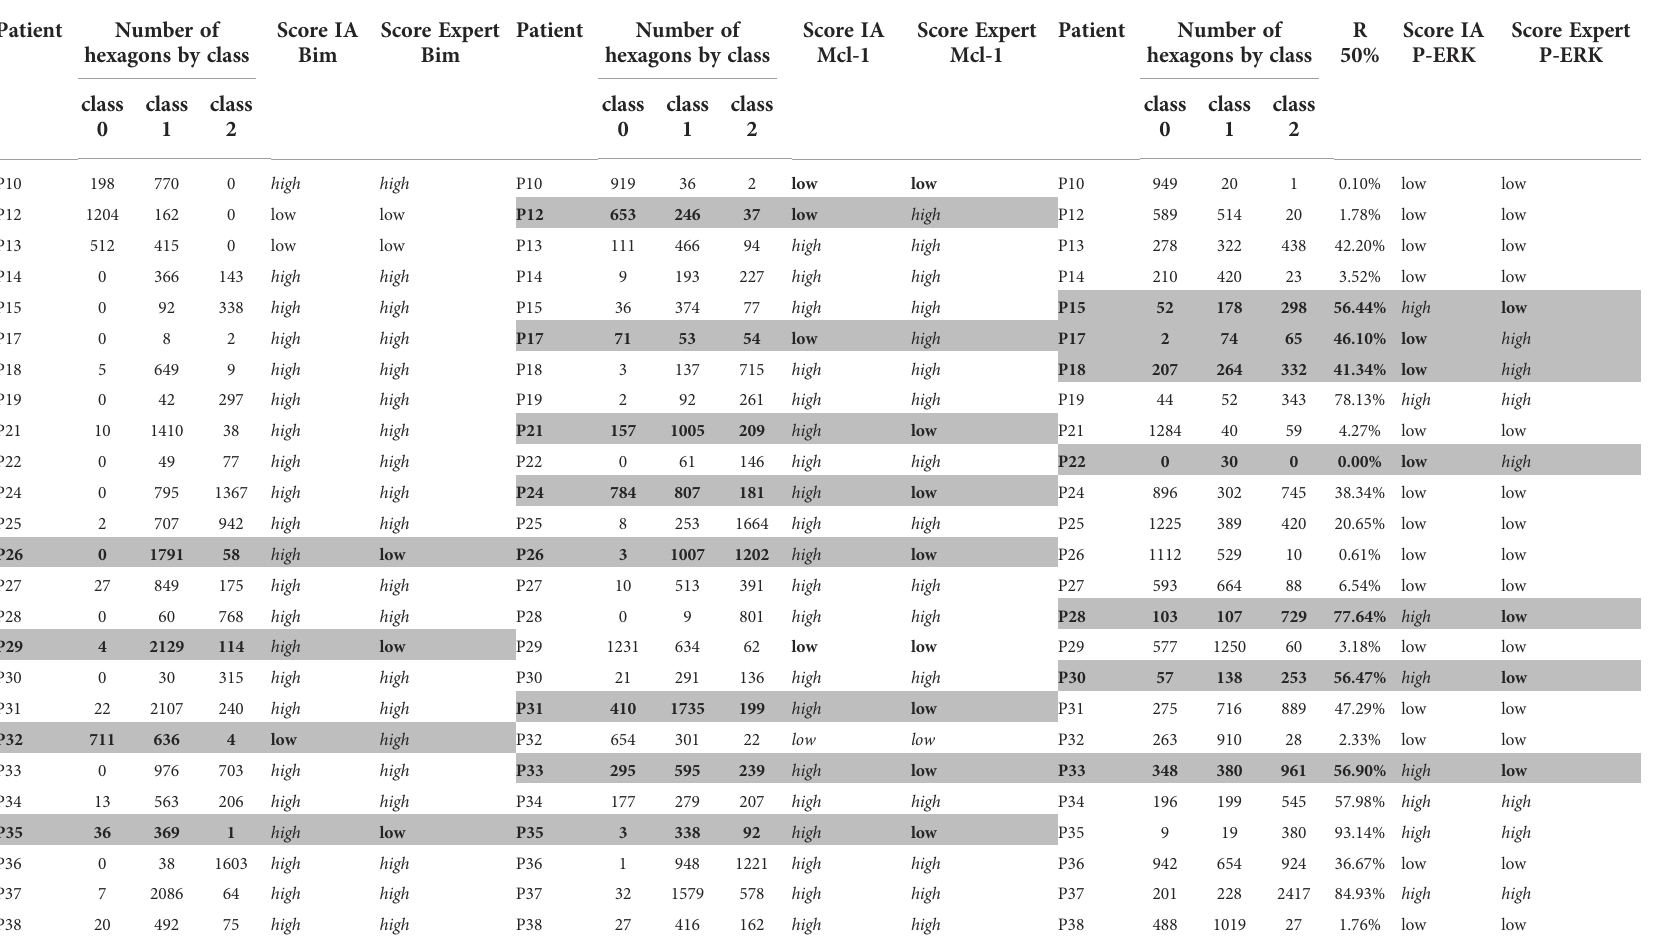
TABLE 4 Distribution in three classes by IP but only two by expert